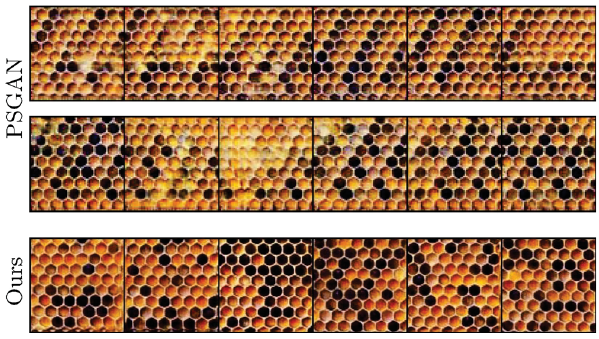
Diversity comparison. Texture samples generated by PSGAN [28] are demonstrated on the top rows. Several of these results seem to have a repetitive pattern and their visual diversity is limited. Our technique is conditioned on co-occurrence statistics and thus generates significantly more diverse